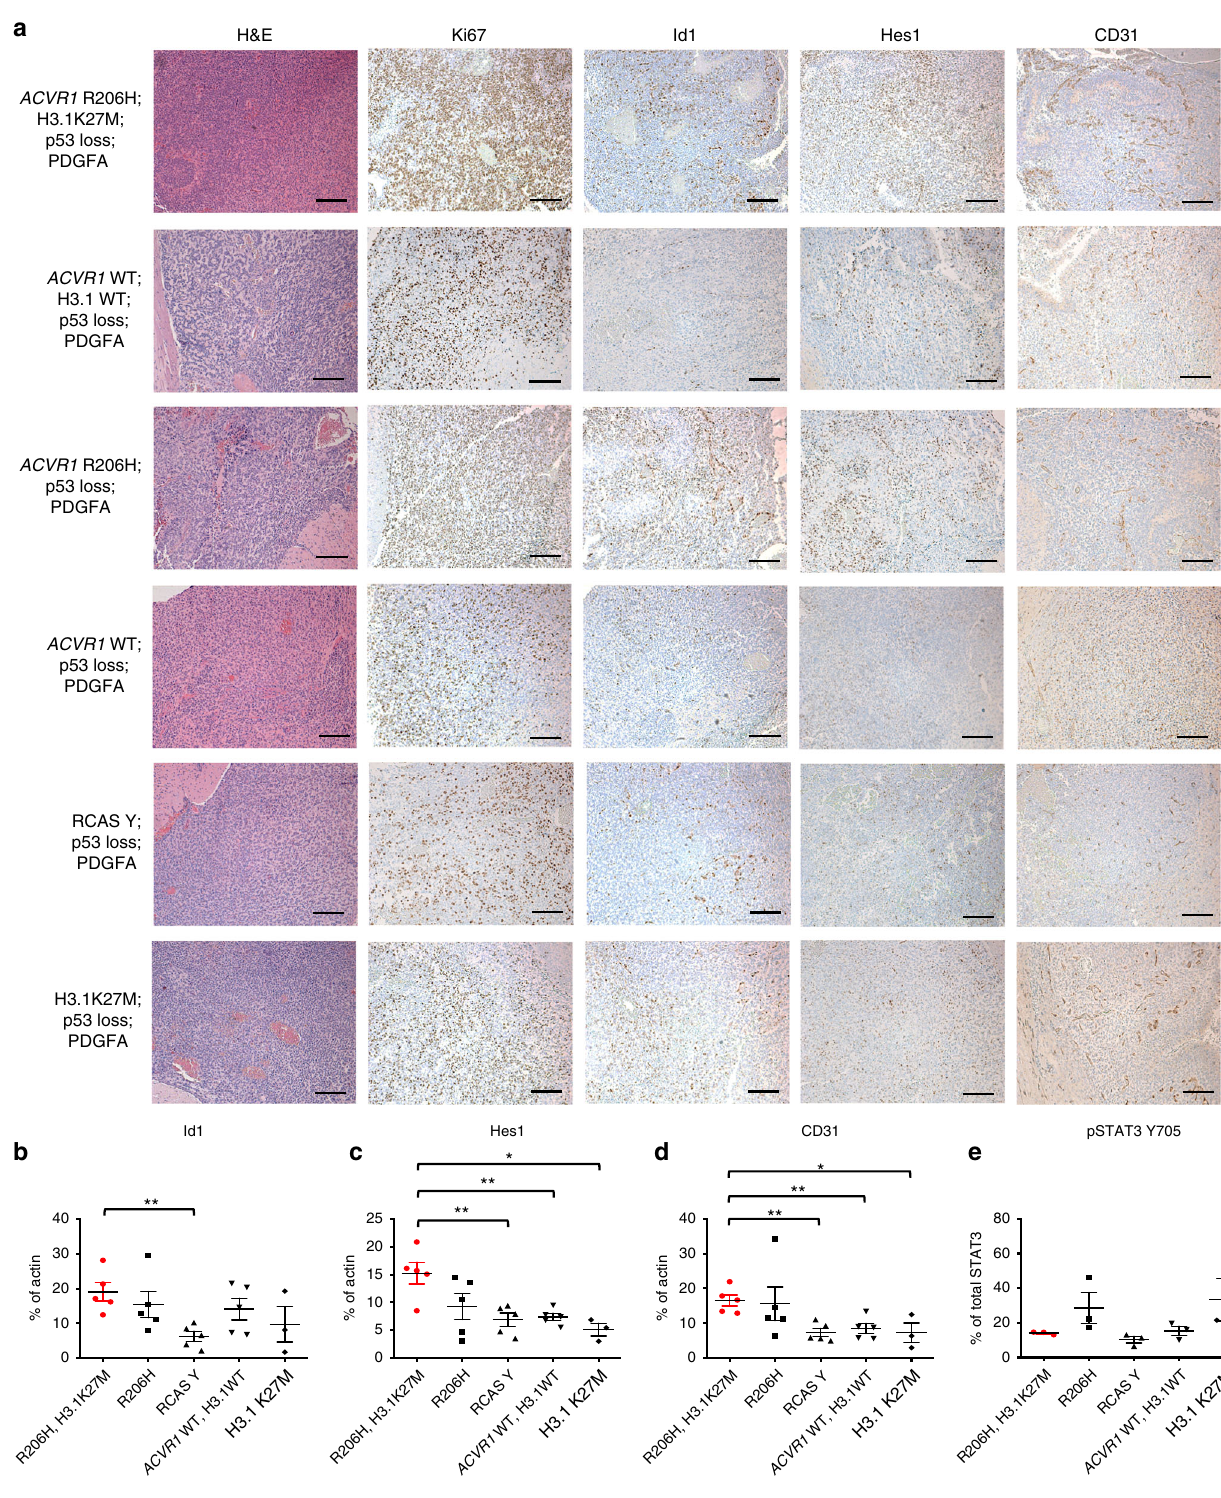
Fig. 5 ACVR1 R206H and H3.1K27M increase BMP signaling and CD31 expression in vivo. a – e All mice were injected with RCAS-PDGFA and RCAS-Cre along with additional RCAS viruses as indicated. a Representative H&E and IHC images of Ki67, Id1, Hes1, and CD31 in all injected groups. ×10 magni fi cation, scale bar = 200 μ M. b – e Western blot analysis of Id1 ( b ), Hes1 ( c ), CD31 ( d ), and pSTAT3 Y705 ( e ) expression from tumor-derived lysates from ( a ). For ( b – d ) all groups n = 5 except RCAS-PDGFA, RCAS-H3.1K27M, and RCAS-Cre injected group where n = 3. For ( e ) all groups n = 3. Data are represented as mean with SEM. * p < 0.05, unpaired t